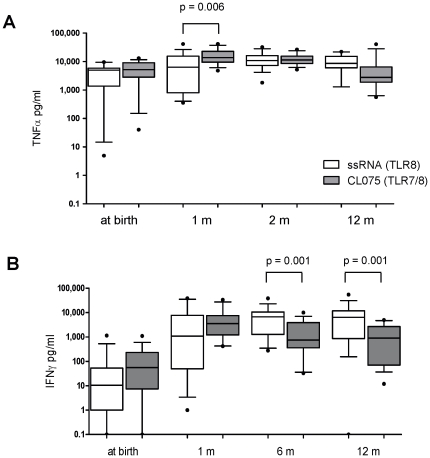
TLR8 agonists induce distinct patterns of TNFα and IFNγ
production across the first year of life.100 µl of whole blood was cultured overnight with ssRNA (TLR8
agonist) and CL075 (TLR7/8) at birth, 1, 2 and 12 months of age. (A)
TNFα and (B) IFNγ cytokine (pg/mL) was measured in supernatants
as described in the Materials and
Methods. Unstimulated values are subtracted from stimulated
values and data are presented as box and whisker plots,
n = 12–15.